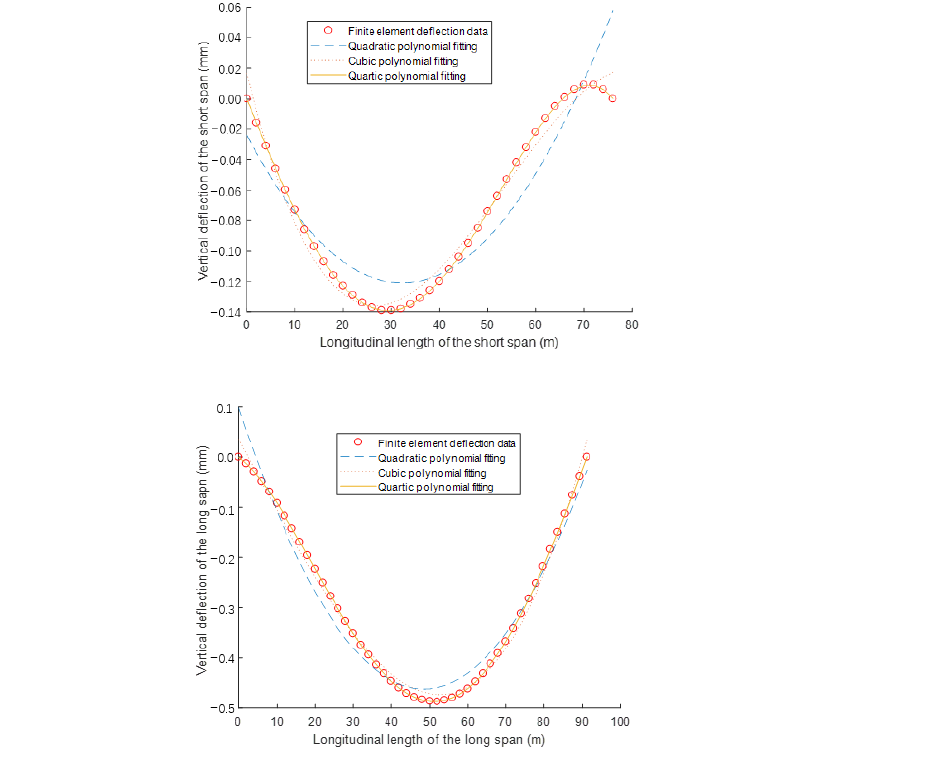
Figure 5. Deflection curves of the finite element analysis.